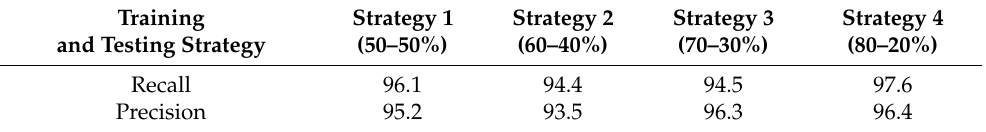
Table 16. Value for Recall and Precision at 4 different training and testing strategies for dataset 3 [45].